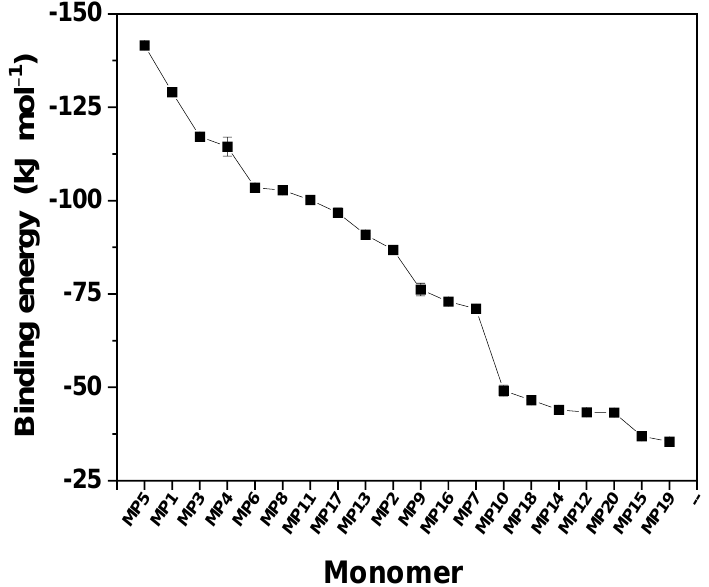
Figure 2. Monomers used in the semi-empirical computational simulations to analyze AMX in wa-